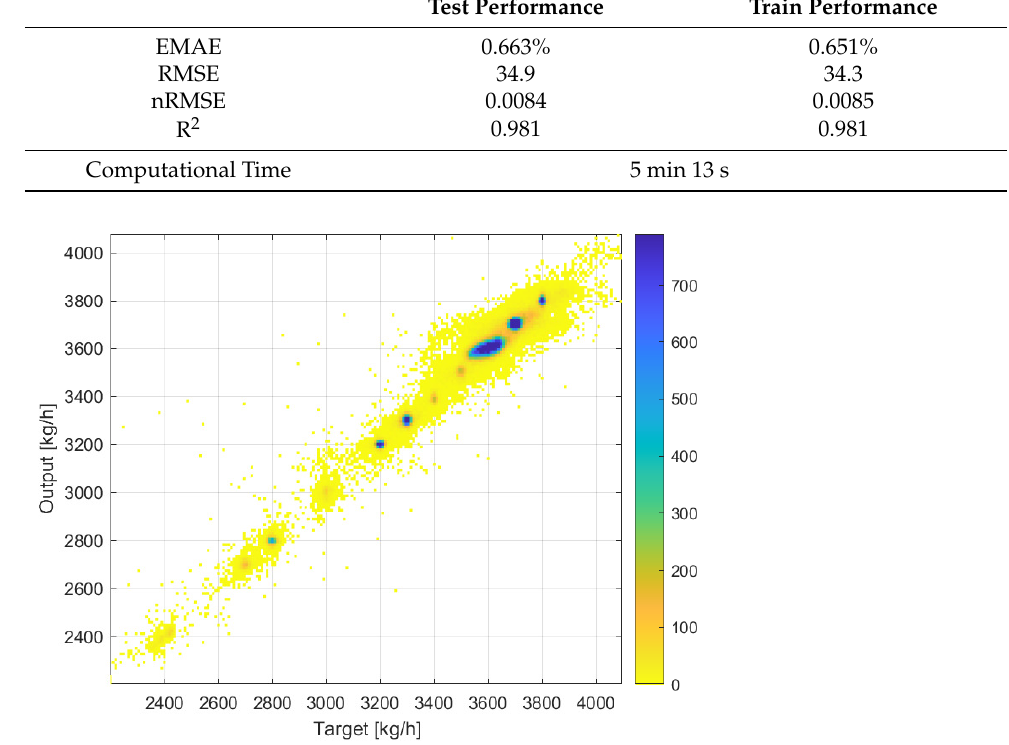
Figure 6. Regression plot of the output vs. the target for the prediction of the steam flow rate that goes to the regenerator, with the data dispersion